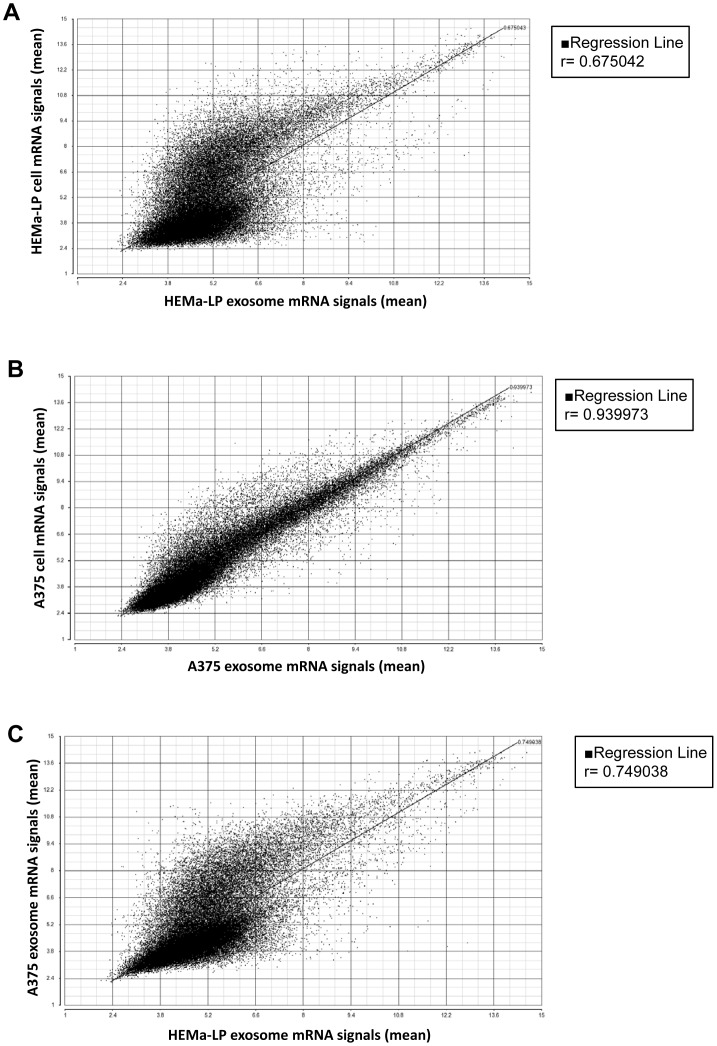
Correlation of mRNA signals between cells and exosomes.Affymetrix HU133 plus 2 arrays were used to analyze mRNA signals in HEMa-LP melanocytes and A375 melanoma cells as well as exosomes from the two cell lines. Two different arrays were performed from two different RNA preparations for each sample. Scatterplots of mRNA signals in HEMa-LP exosomes compared with their originating cells (A), A375 exosomes compared with their originating cells (B), and A375 exosomes compared with HEMa-LP exosomes (C). Regression analysis showed that mRNA signals in cells versus exosomes were correlated. mRNA signals in A375 exosomes were also correlated with those in HEMa-LP exosomes.